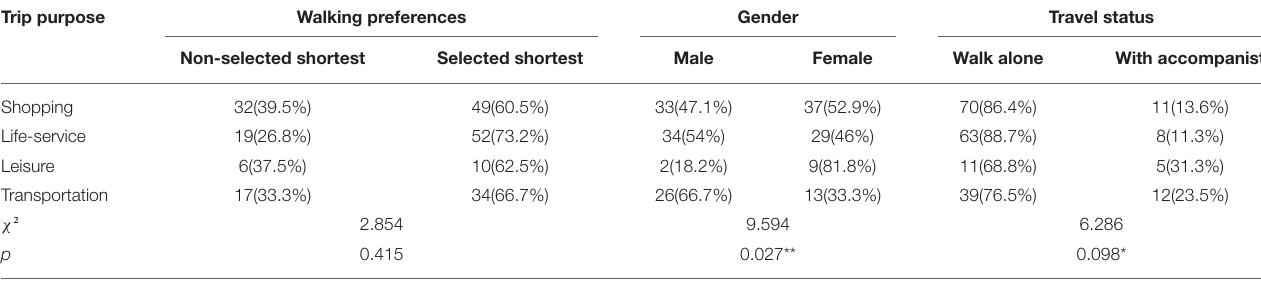
TABLE 3 | Chi-square test between trip purpose and walking preferences, gender, and travel status.